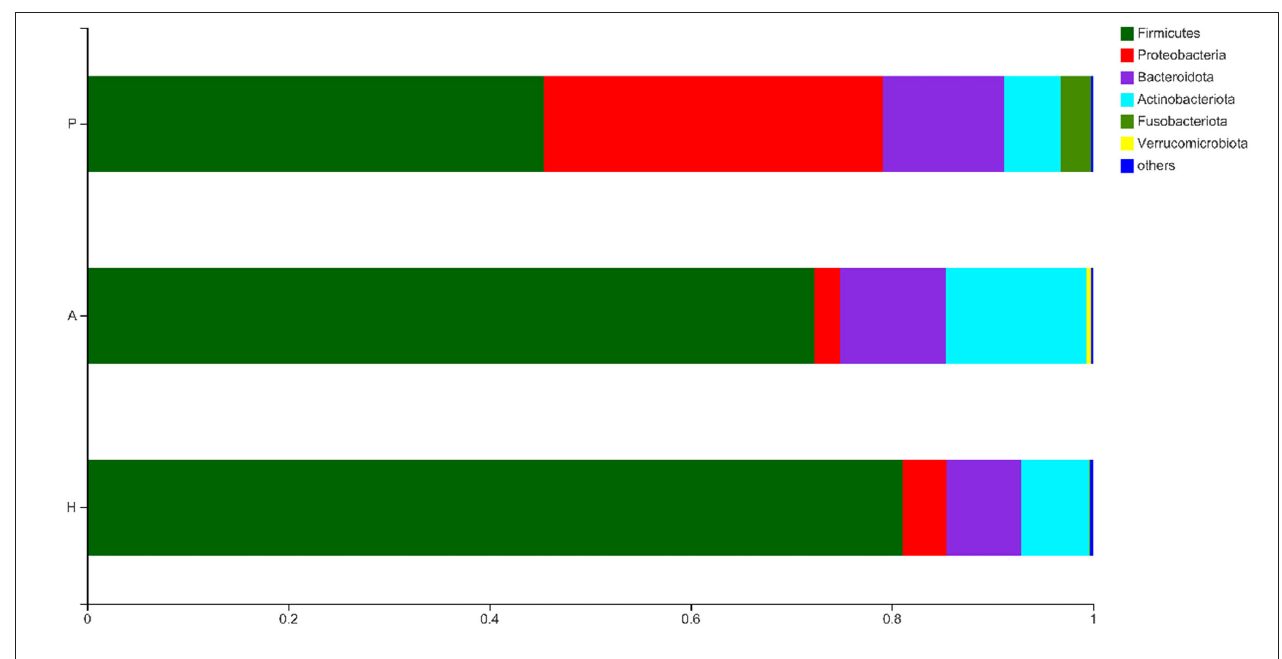
FIGURE 6 | Community barplot analysis of bacteria at the phylum